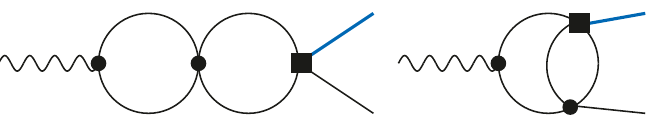
Figure 5 . The Feynman diagrams contributing to the non-trivial analyticity properties of the form factors W + ;S ( z ) at two loops, restricted to two-pion intermediate states. The meaning of the lines and of the vertices is as in (cid:12)gure 2. The second diagram, with the vertex topology, has a complex absorptive